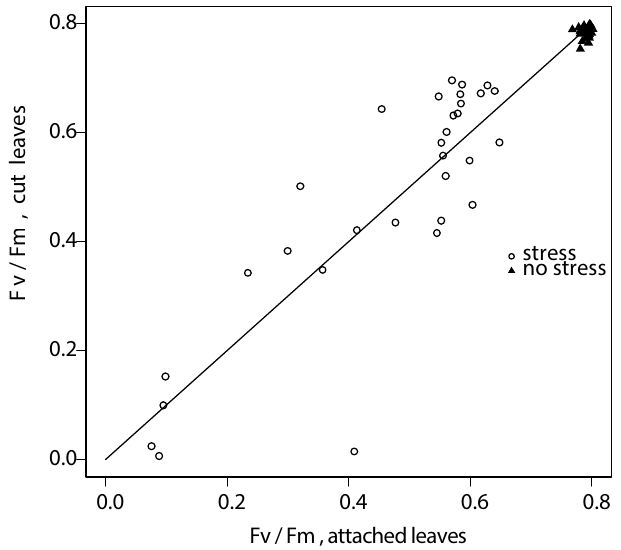
Figure 1 . FT of 31 barley genotypes (E1, E2) assessed with chlorophyll fluorescence after freezing tests and recovery. Varietal mean F v /F m of leaves still attached to the plant vs. those cut prior to the freezing test for experiments with a stress temperature of − 13 °C. F v /F m measured on non-stressed leaves in E2 in parallel to the stressed leaves after time elapsed for the freezing test and 24 h of recovery is shown with filled